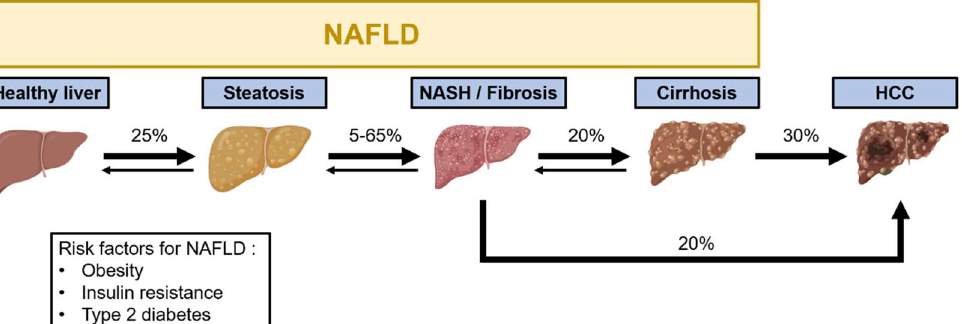
Figure 1. Progression from non-alcoholic fatty liver disease (NAFLD) to hepatocellular carcinoma (HCC). The sequential progression of the disease through the different stages is illustrated. The directions of arrows indicate whether stages are reversible or not. Percentages are related to the fraction of patients progressing to the next stage [8–10,12–15]. Associated risk factors are indicated. Artwork used to construct this figure is freely available from BioRender (https://biorender.com/ (accessed on 1 June 2022)).